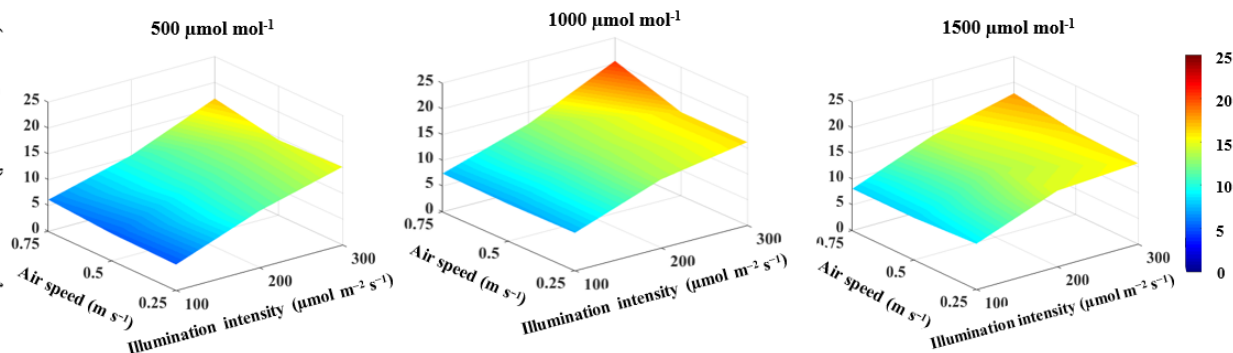
Figure 3. Effect of CO 2 concentration, illumination intensity and air speed on the photosynthetic rate of lettuce plants grown under artificial lighting.